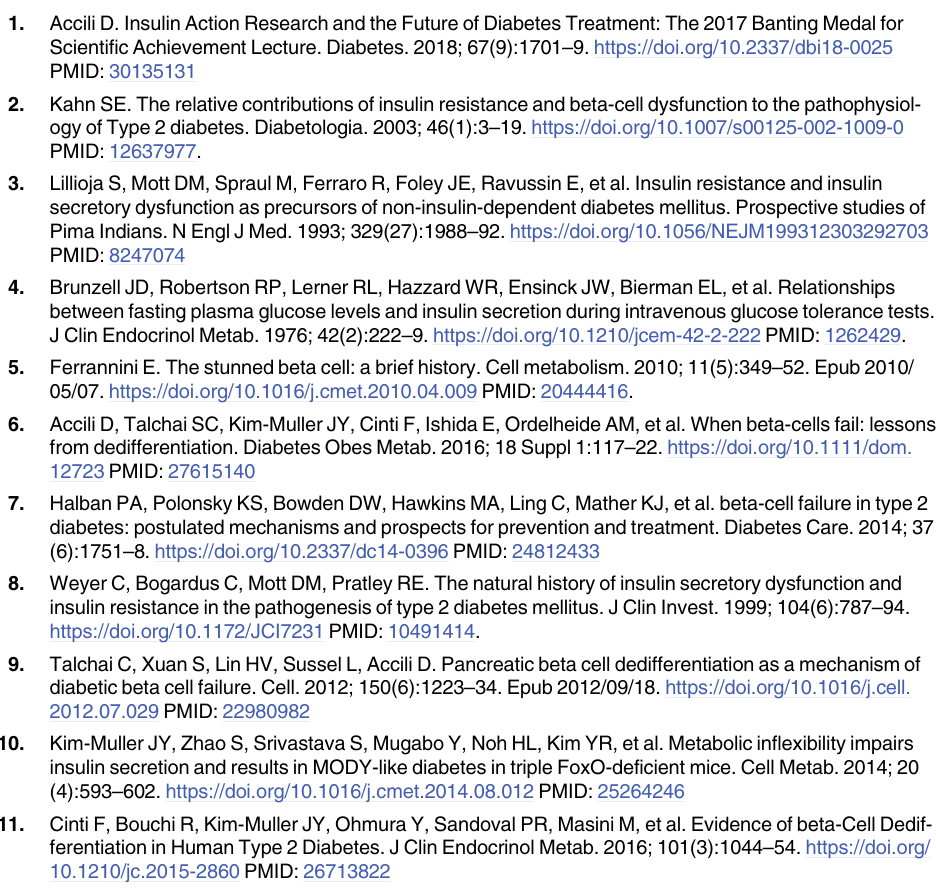
S4 Fig. Uncropped Western blot